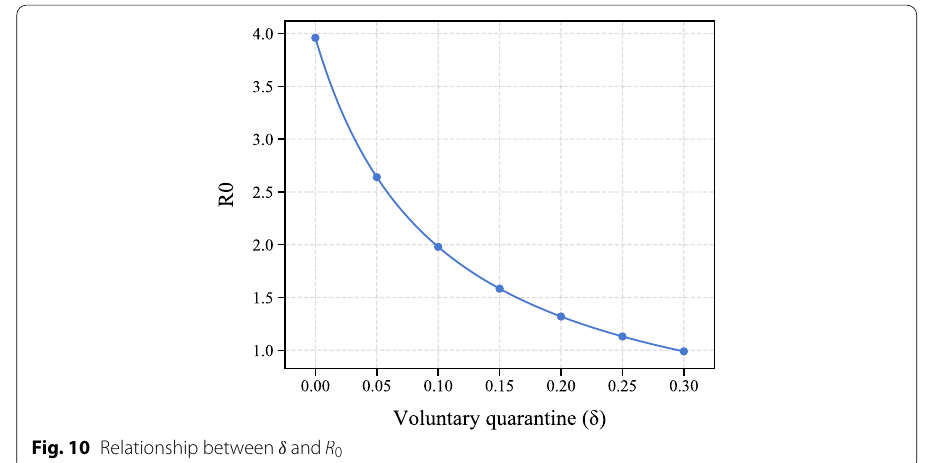
Fig. 10 Relationship between δ and R